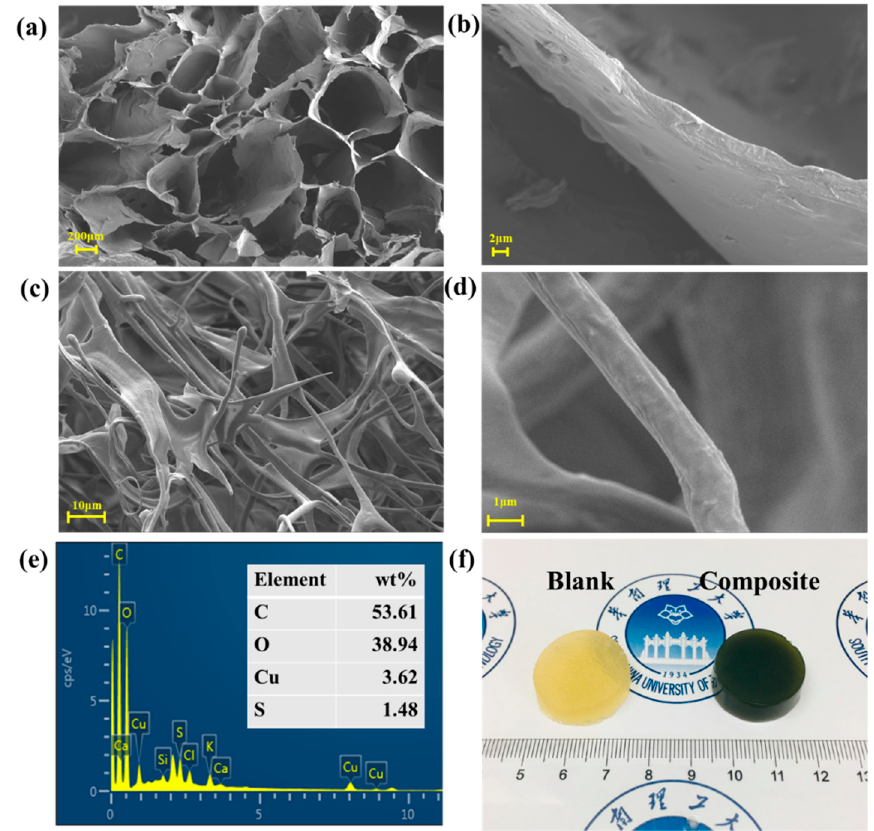
Figure 3. ( a , b ) SEM images of blank hydrogels; ( c , d ) SEM images of CuS@corn stalk/chitin composite hydrogels; ( e ) energy dispersive spectrometer (EDS) about the surface of CuS@corn stalk/chitin composite hydrogel; ( f ) digital photograph of blank hydrogel and composite hydrogel.